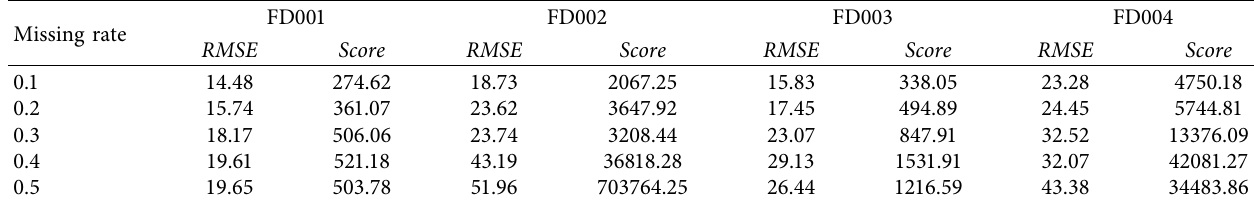
Table 6: The results of the RUL prediction with data imputation for different missing data